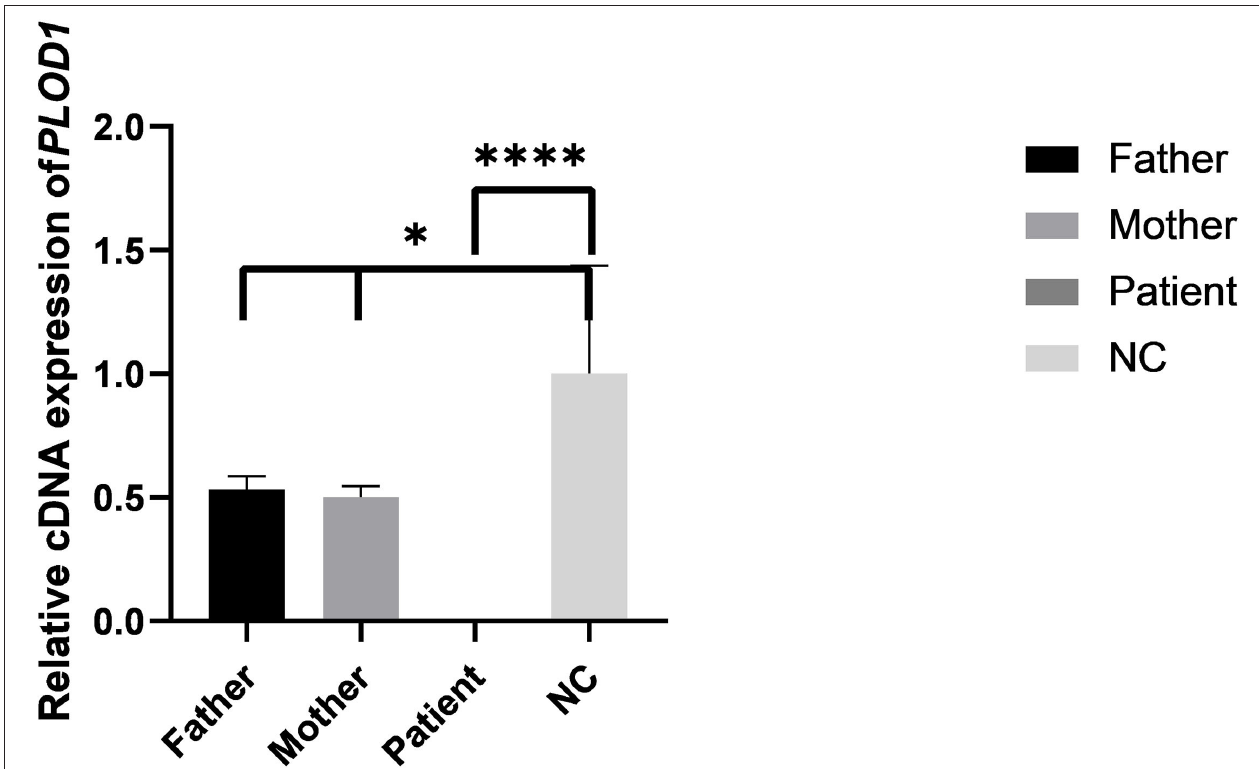
FIGURE 6 | The results of qPCR in pedigree and normal control (NC). Difference of qPCR expression levels in Father, Mother, Patient, and NC (* P < 0.05, **** P < 0.0001).